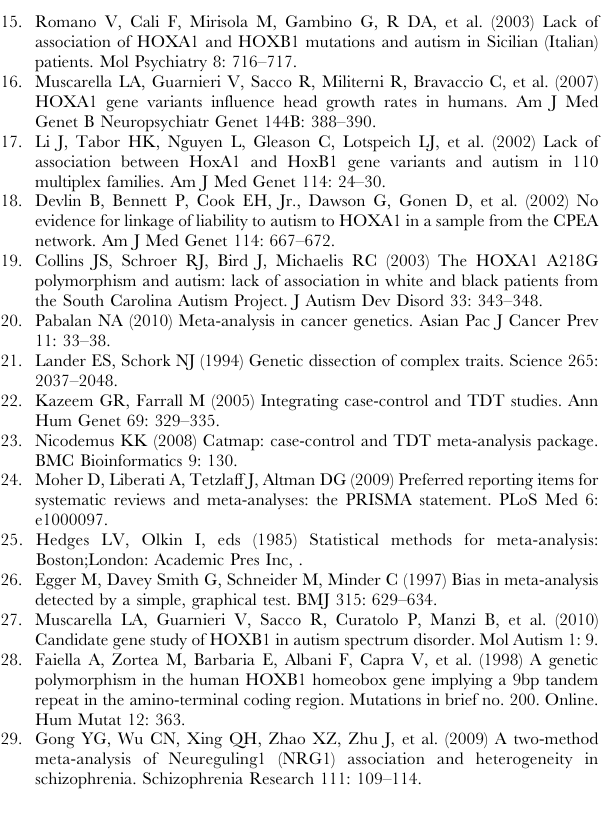
Figure S2 The funnel plots of the HOXB1 nINS/INS variant for ASD. Egger’s test: P = 0.591.